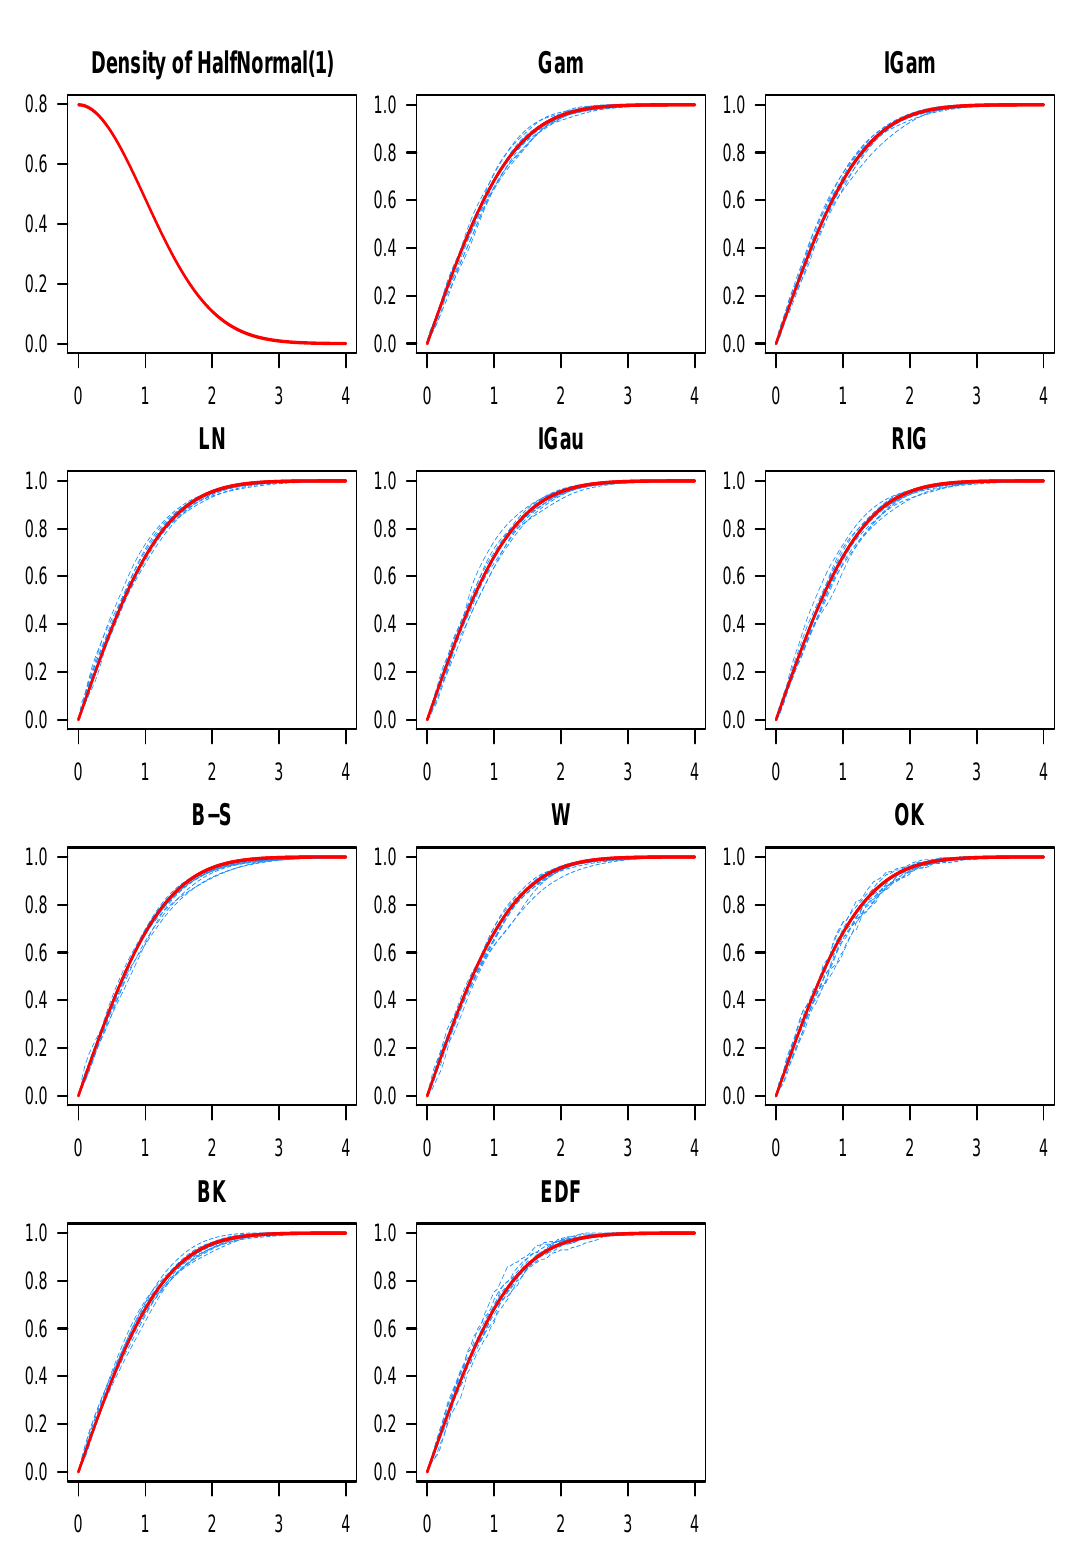
Figure 6. The HalfNormal ( 1 ) density function appears on the top-left, and the target c.d.f. is depicted in red everywhere else. Each plot has ten estimates in blue for the HalfNormal ( 1 ) c.d.f. using one of the ten estimators (the name of the corresponding kernel is indicated above each graph) and n =